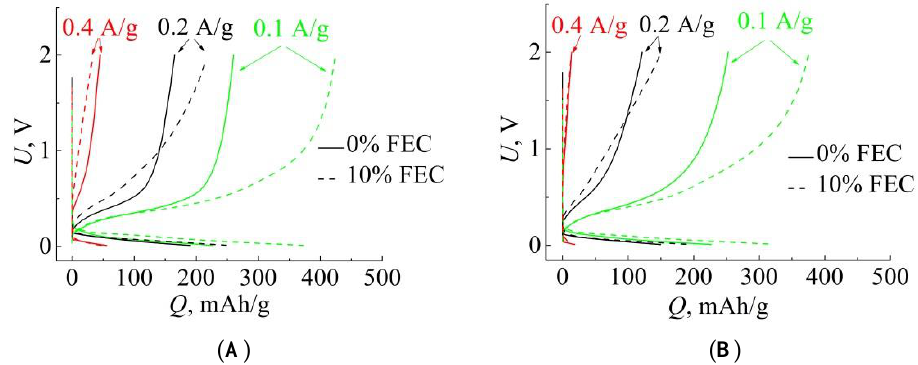
Figure 7. Charge – discharge curves at various rates of electrodes in pairs ( A , B ) after the 300th cycle.